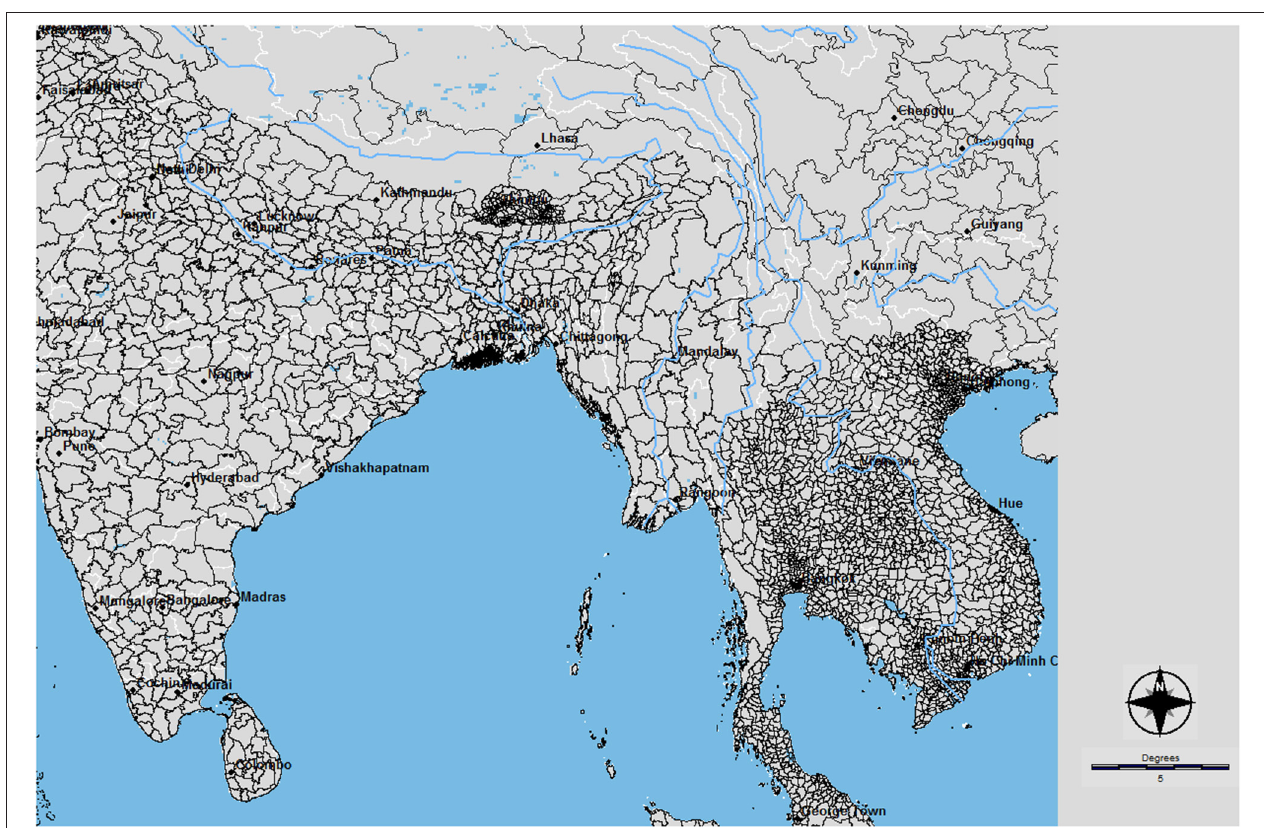
FIGURE 2 | FAO Global Administrative Unit Layer (GAUL) Level